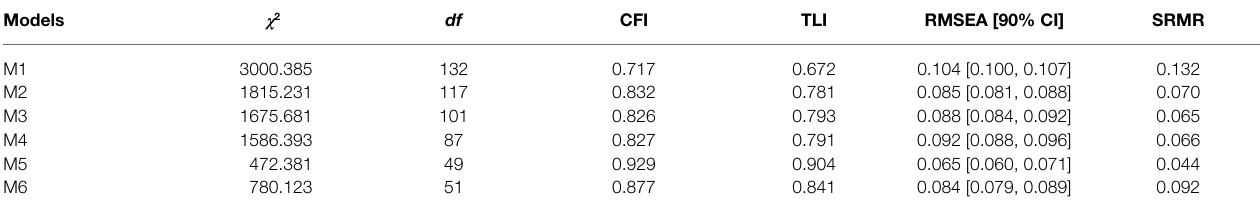
TABLE 2 | Confirmatory factor analysis of the PRFQ. Models